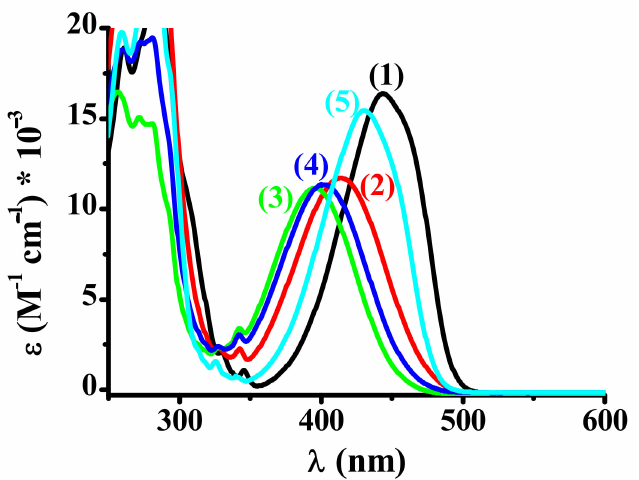
Figure 1. UV–visible absorption spectra of the Naphthalimide derivatives in chloroform: (1) Napht-1, (2) Napht-2, (3) Napht-3, (4) Napht-4, and (5)